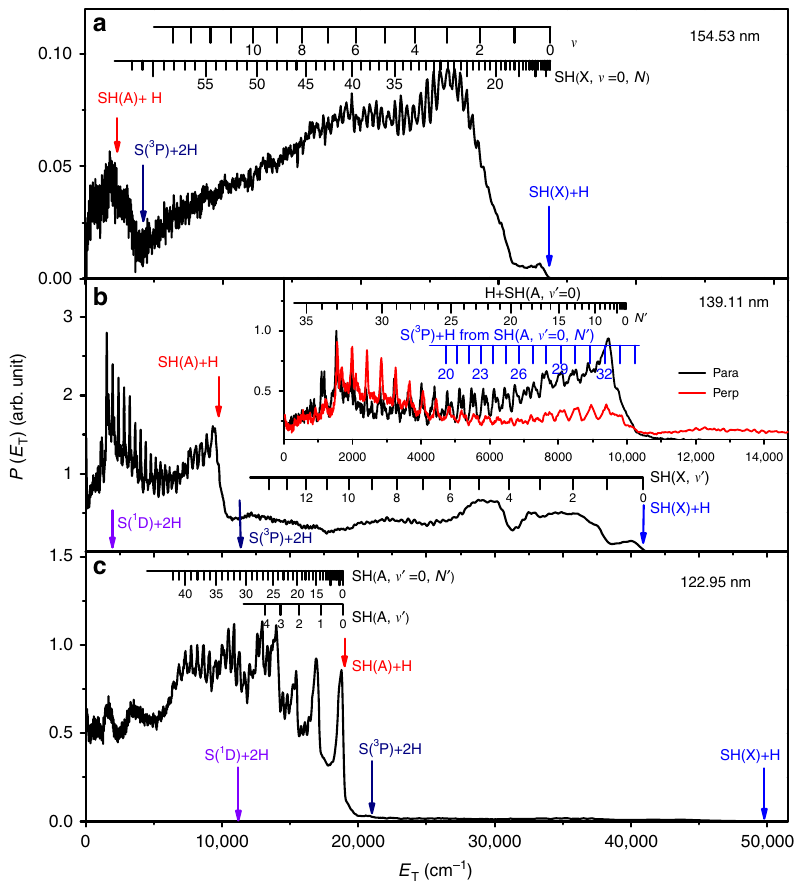
Fig. 1 Translational energy spectra from H 2 S photodissociation. P ( E T ) spectra derived from H atom time-of- fl ight spectra following photodissociation of H 2 S at a 154.53 nm, b 139.11 nm, and c 122.95 nm with the detection axis aligned at the magic angle ( θ = 54.7°) to the polarization vector of the photolysis laser radiation ( ε phot ). The inset in b shows an expanded view of the low E T part of the corresponding θ = 0° and 90° data. The combs on these spectra show the E T values associated with formation of H atoms in conjunction with selected rovibrational levels of the primary SH(X) and SH(A) fragments and, in b , with H atoms formed by predissociation of primary (SH(A, v ΄ = 0, N ΄ ) fragments. The maximum E T values associated with each of channels (1) – (4) are shown by vertical blue, red, navy, and violet arrows, respectively; the navy arrow indicates the E phot − Δ E (3) value at which we separate the spectrum into primary H + SH(X) and (direct or indirect) three-body product formation. Source data are provided as a Source Data fi